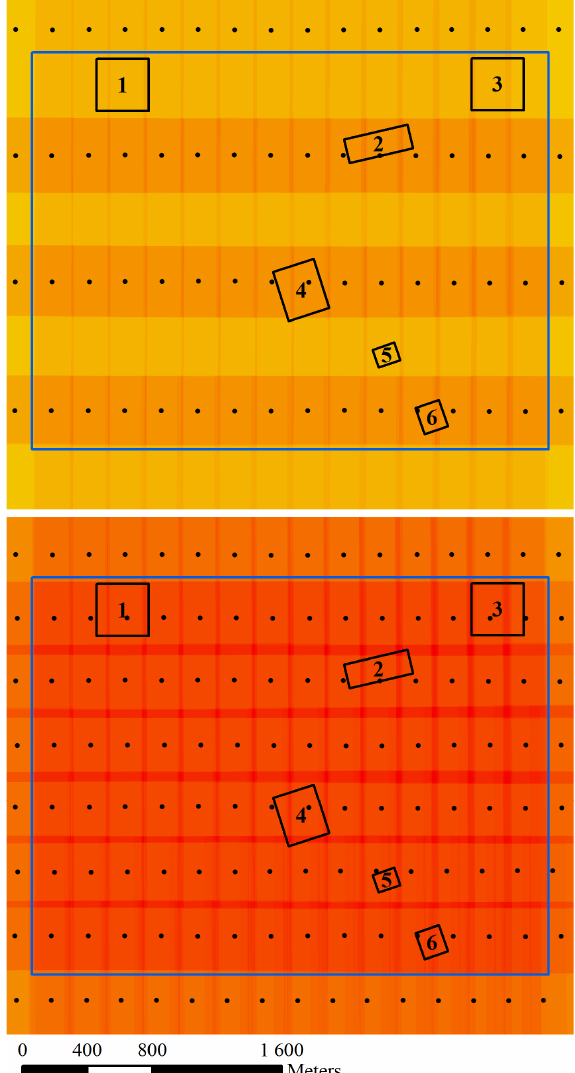
Figure 4. Location of test areas (from 1 to 6 marked with black outlines) within the test field (marked with blue outline). In background images overlap (cameras position marked with black dot). Top: for 80/60 configuration (areas with 10 overlapping images in yellow, 15 – in orange); Bottom: for 80/80 configuration (light red indicates areas with 25 overlapping